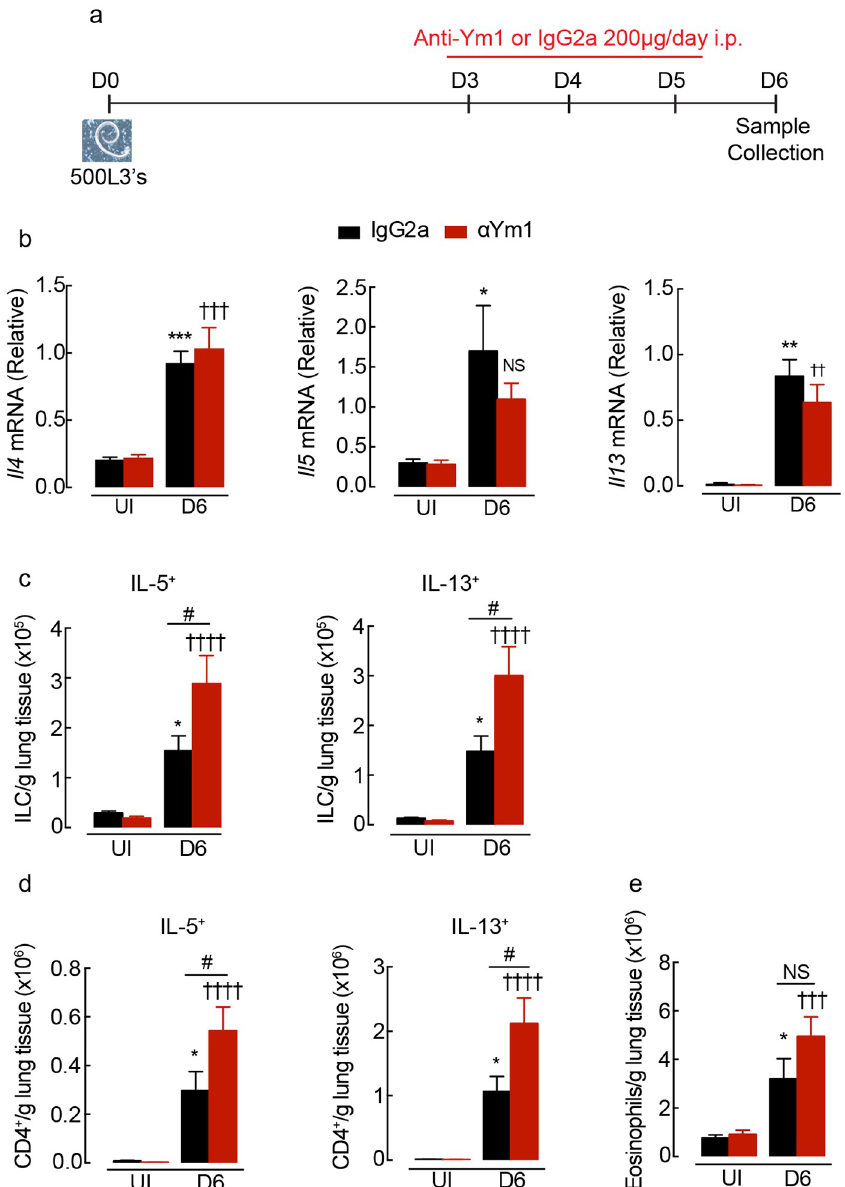
Fig 3. Adaptive Ym1 limits type 2 cytokine production in the lung during infection. (a) Time-line of infection with N . brasiliensis and dosing with anti-Ym1 or IgG2a. (b) Expression of Il4 , Il5 and Il13 mRNA in whole lung tissue of uninfected (UI) or N . brasiliensis (500 L3’s) infected mice (D6) treated intraperitoneally with anti-Ym1 or IgG2a ( n = 6 per group; data are shown as mean ± sem; two-way ANOVA with Sidak multi-comparison test; NS not significant, � P < 0.05, �� P < 0.01 ��� P < 0.001 compared to UI IgG2a treated; ✝✝ P < 0.01, ✝✝✝ P < 0.001 compared to UI anti-Ym1; data representative of 3 independent experiments). (c) The number of ILCs expressing intracellular IL-5 or IL-13 within the lungs of mice as in b . Single cell lung suspensions were stimulated ex vivo with PMA and ionomycin, graphs show absolute number of cytokine positive cells per g of lung tissue ( n = 6 per group; data are shown as mean ± sem; two-way ANOVA with Sidak multi-comparison test; � P < 0.05 compared to UI IgG2a treated; ✝✝✝ P < 0.001, ✝✝✝✝ P < 0.0001 compared to UI anti-Ym1; NS not significant, #P < 0.05 IgG2a infected compared to anti-Ym1 infected mice; data representative of 3 independent experiments). (d) Expression of IL-5 and IL-13 in CD4 + T cells from mice as described in b ( n = 6 per group; data are shown as mean ± sem; two-way ANOVA with Sidak multi-comparison test; � P < 0.05 compared to UI IgG2a treated; ✝✝✝✝ P < 0.0001 compared to UI anti-Ym1; #P < 0.05 IgG2a infected compared to anti-Ym1 infected mice; data representative of 3 independent experiments). (e) Absolute number of eosinophils from lungs of mice as in b ( n = 6 per group; data are shown as mean ± sem; two-way ANOVA with Sidak multi- comparison test; � P < 0.05 compared to UI IgG2a treated; ✝✝✝ P < 0.001 compared to UI anti-Ym1; NS not significant, IgG2a infected compared to anti-Ym1 infected mice; data representative of 3 independent experiments).